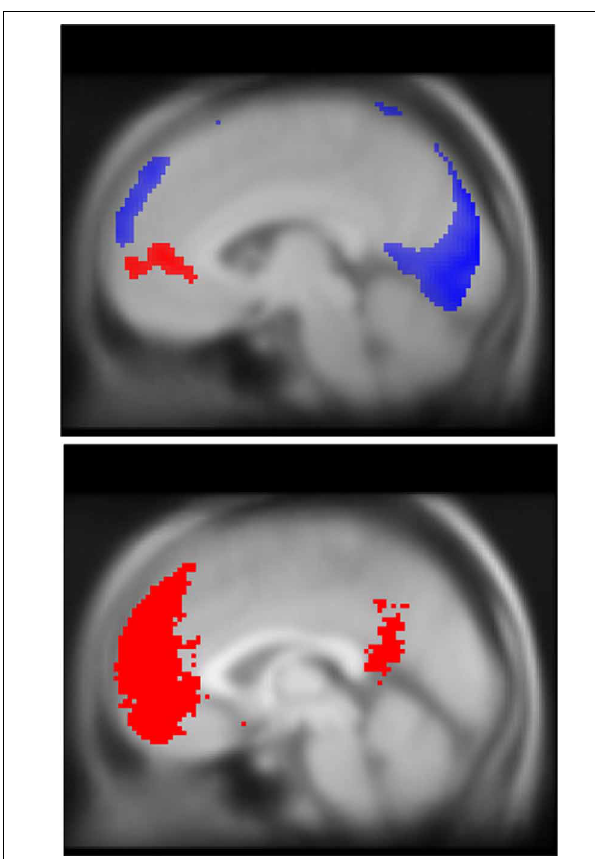
FIGURE 4 | DMN deactivations during stop trials (blue, top) and correlation with TUT reports (red, top), and mask used for ROI analysis (red, bottom). Note that while both task-unrelated thoughts and response inhibition engage the DMN, they recruit spatially unique regions of the mPFC. To facilitate comparison of spatial topography for EAT and TUT-related DMN activity, both activation maps are overlaid on a single MNI structural brain. In blue, significant deactivations during EAT stop trials (pFWE peak < 0.05, k threshold = 5 contiguous voxels). In red, increased self-reported TUT predicts greater mPFC BOLD activation, pFWE cluster < 0.05, region-of-interest analysis with DMN mask volume (bottom image shown in red), k threshold = 685 contiguous voxels. DMN mask generated using automated meta-analysis for term “mPFC” on neurosynth.org, z -score threshold > 4 (see Methods for further details). Statistical parametric maps superimposed on SPM canonical anatomical image, average of 305 T1-weighted images. Top image shown at MNI X = − 5, bottom at X = 0.